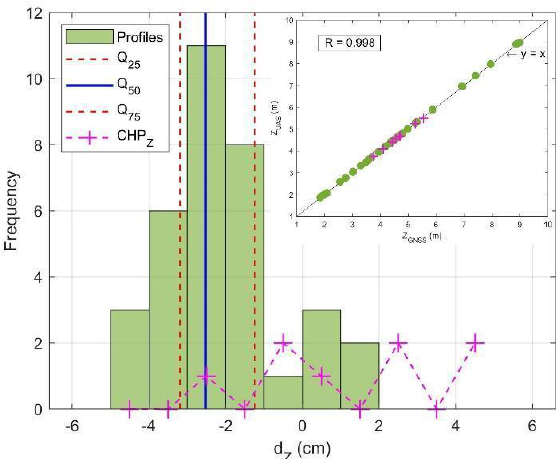
Figure 3 . Differences in elevation between points measured in the GNSS survey and the elevation obtained UAS DSM. Q 25 , Q 50 and Q 75 are the quartiles of deviations in profiles points. The plus-dash line illustrates the histogram of CHP Z . In the top right is represented the linear regression of the vertical position. Circles correspond to P and plus sign correspond to CHP